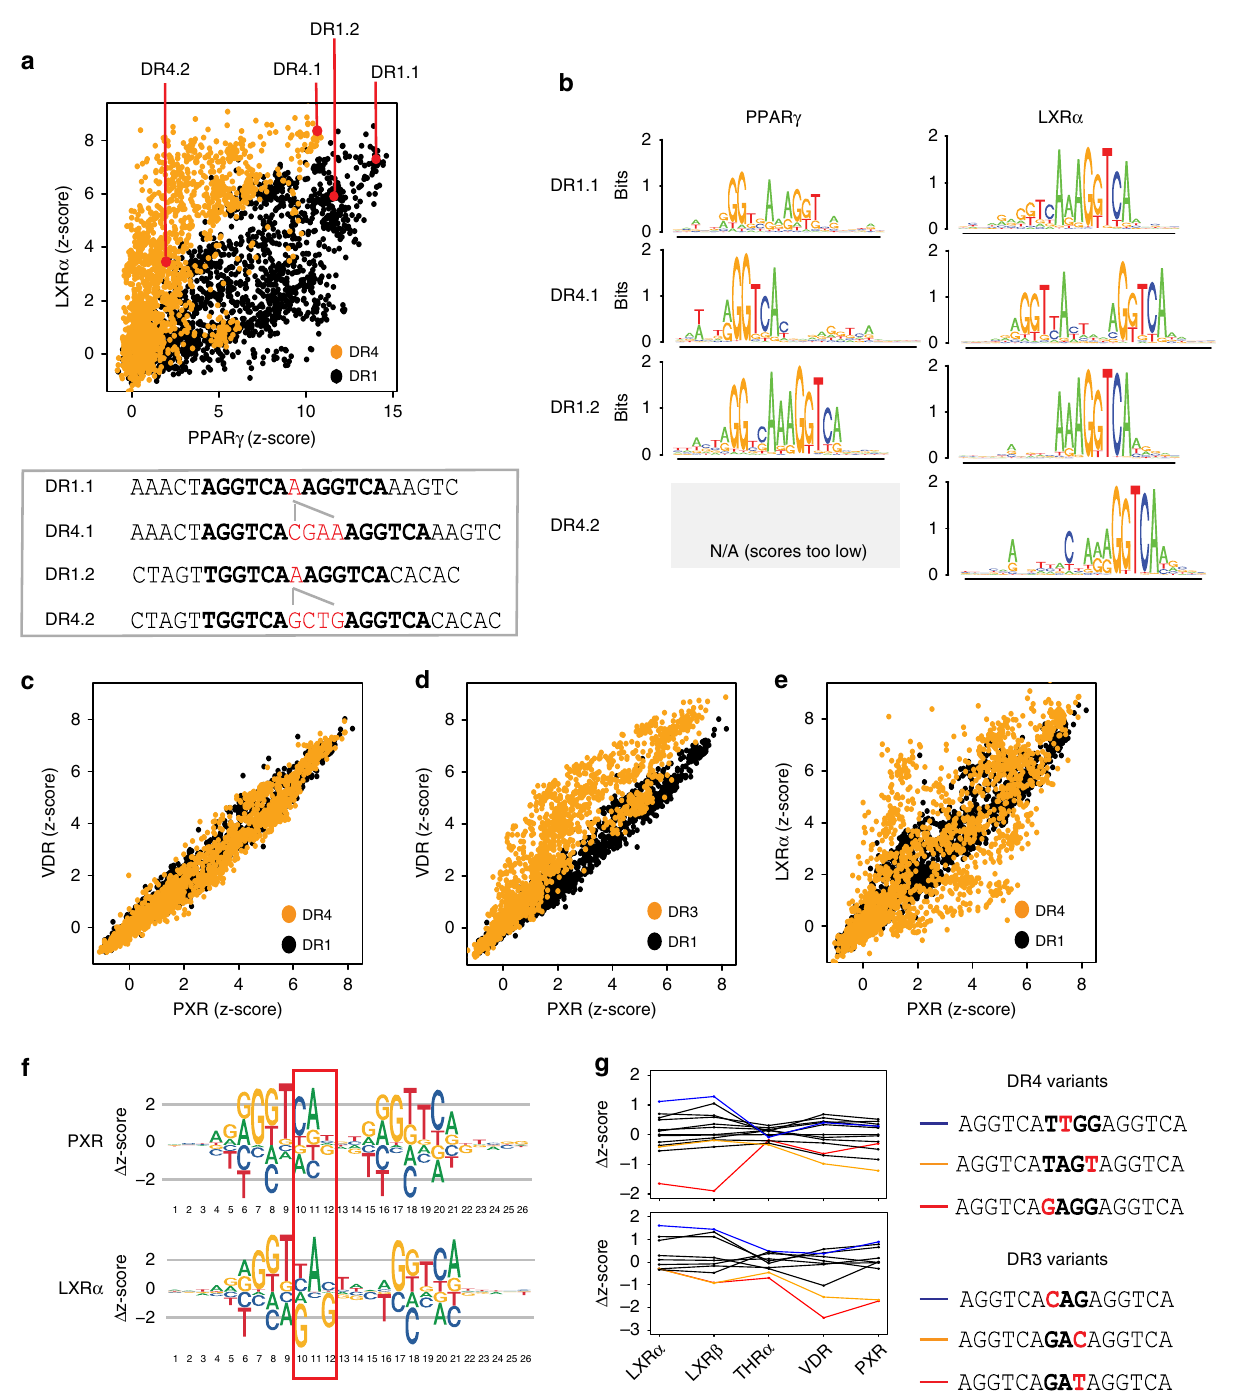
Fig. 5 NR speci fi city differences. a Scatter plots of LXR α and PPAR γ binding to DR1 and DR4 sites. Each spot is the average of ∼ 5 replicates for each unique DNA sequence ( ∼ 1600 at each spacer length) on the PBM. DR1 and DR4 spacer-variant sequences are shown in the box below panel. b Binding logos generated for LXR α and PPAR γ for the spacer-variant seed sequences from a are shown. c Scatter plots as in 5a of VDR and PXR binding to DR1 and DR4 sites. d Scatter plots as in 5a of VDR and PXR binding to DR1 and DR3 sites. e Scatter plots as in 5a of LXR α and PXR binding to DR1 and DR4 sites. f DR4 z-score logos, directly representing Δ z-scores of SNV binding, are shown for LXR α and PXR. Δ z-scores are calculated (separately for each NR) as the difference from the median of all SNV variants. g Differential binding of NRs to spacer-sequence variants. (Top panel) Binding is shown for fi ve NRs to the DR4 seed sequence 5 ’ -AGGTCATAGGAGGTCA-3 ’ and all 12 SNVs of the spacer region (spacer region in bold). Δ z-scores are calculated as in 5f . (Bottom panel) Binding is shown for fi ve NRs to the DR3 sequence 5 ’ -AGGTCAGAGAGGTCA-3 ’ and all nine corresponding SNVs of the spacer region (spacer region in bold). Examples of highly variant spacer sequences are indicated. Source data are provided as a Source Data fi